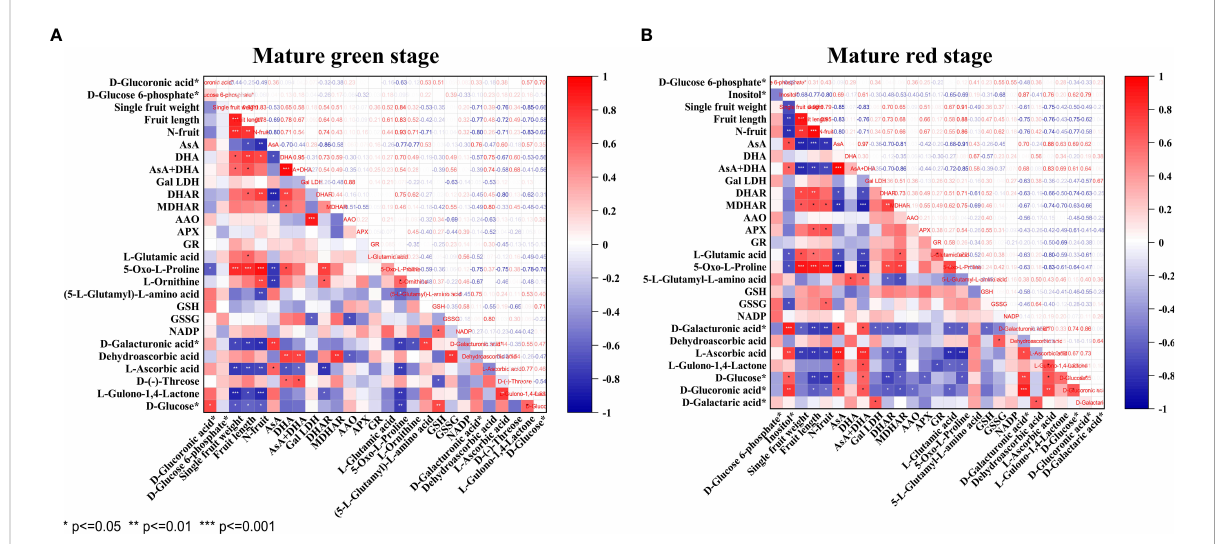
FIGURE 5 Correlation analysis of vitamin C metabolism related components, enzymes, fruit growth parameters and pericarp N concentration for pepper fruits at mature green (A) and red (B) stage. Pearson ’ s correlation coef fi cients are presented. Asterisk indicates statistically signi fi cant correlation at different level of P value (* P <0.05, ** P <0.01, *** P